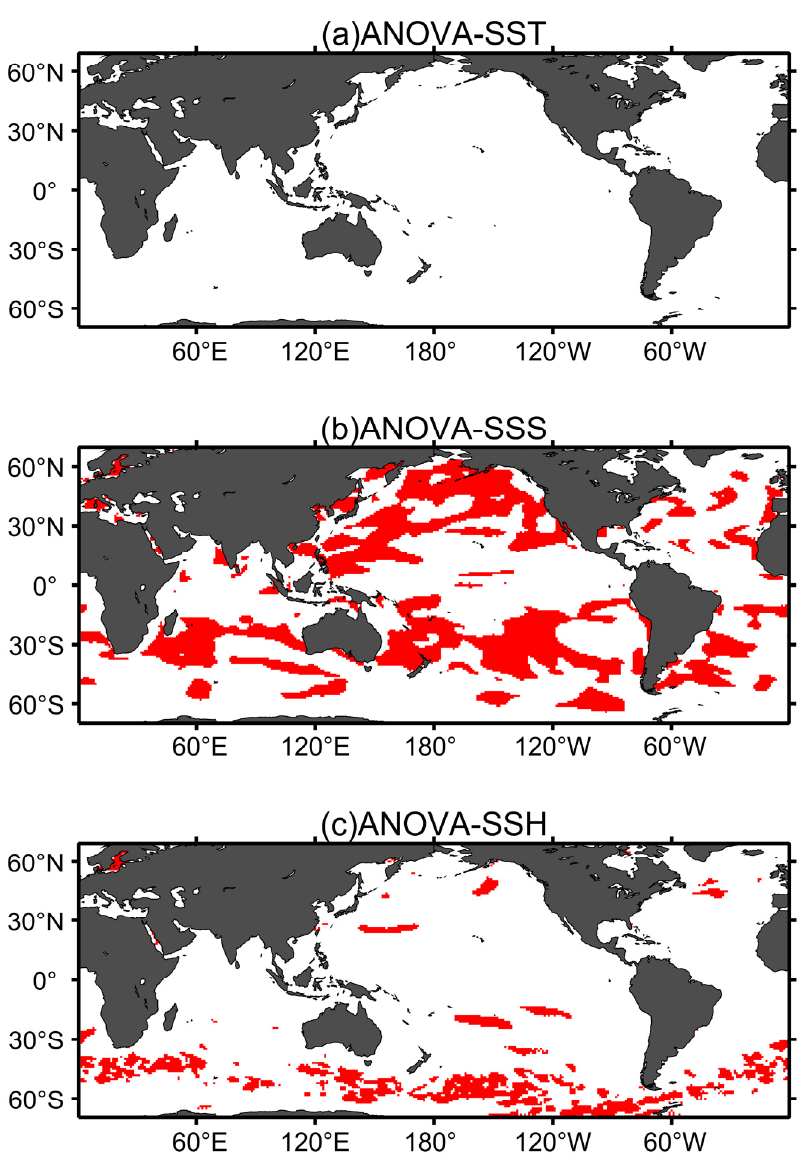
Figure 10. Horizontal distribution of results by ANOVA (a) SST (b) SSS (c) SSH (red: p < 0.05 white: p > 0.05).